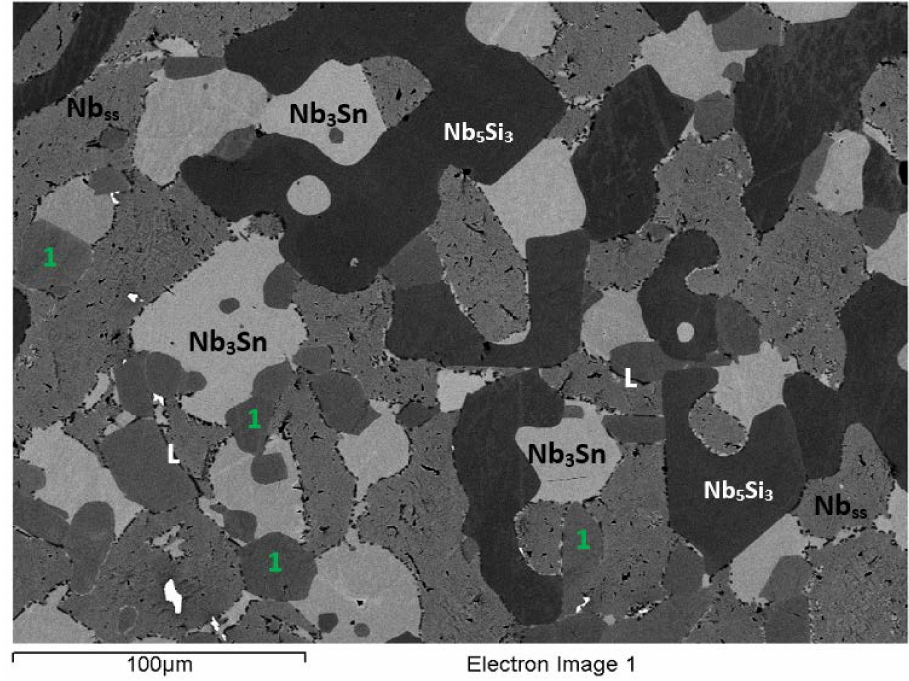
Figure 7. BSE image of the microstructure of EZ6-HT1. The Hf-rich Nb 5 Si 3 is indicated with the number 1, and thin strips of Laves phase at the interface between Nb ss and the aforementioned silicide are shown with L. Bright phase on the left-hand side of number 1 in the bottom left-hand corner is HfO 2 . The A15-Nb 3 X is shown as Nb 3